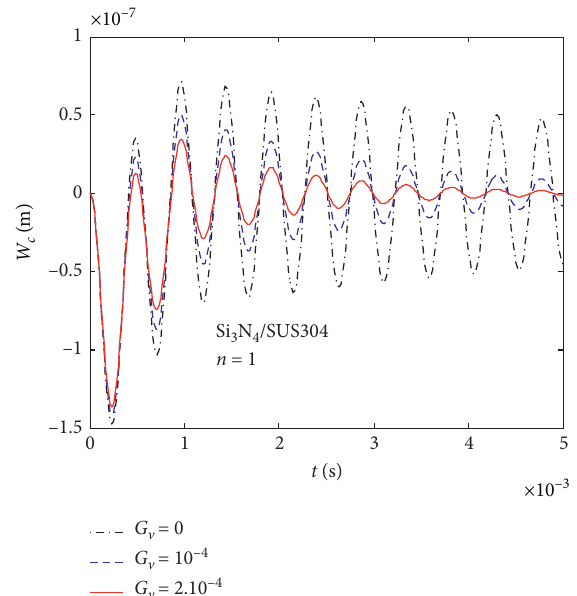
Figure 4: The dependence of w